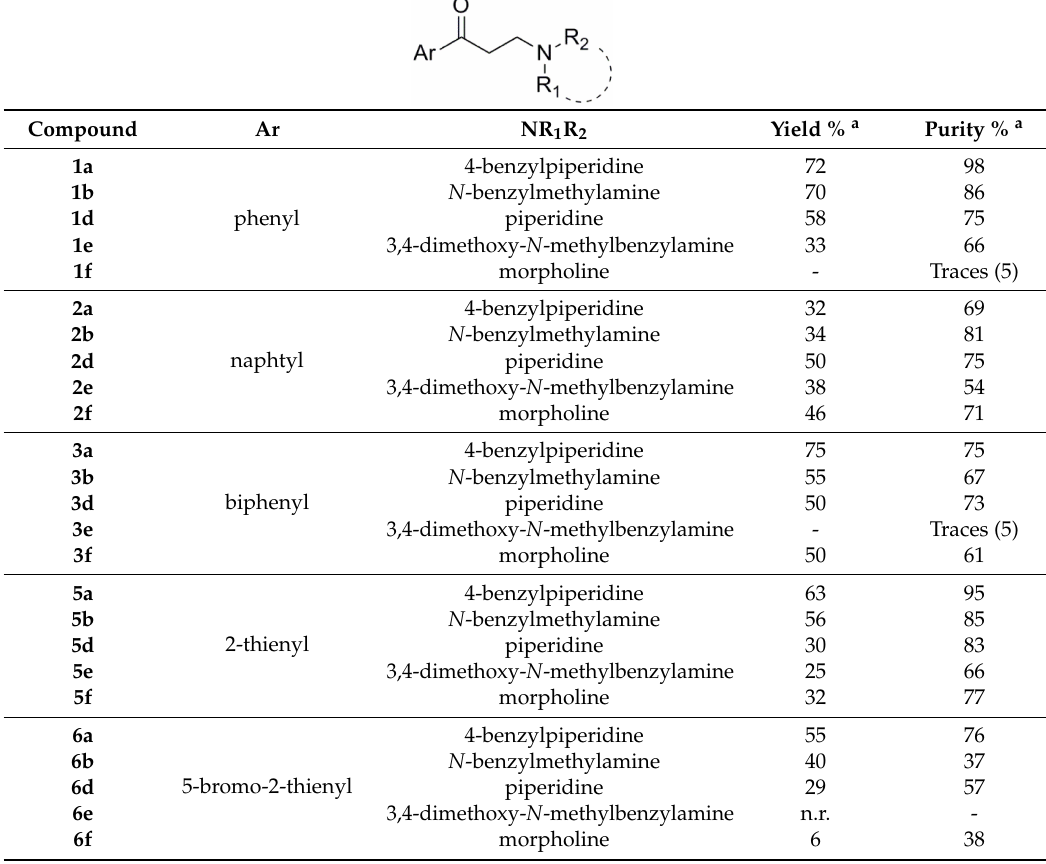
Table 3. Yield and purity of compounds 1a – 6f